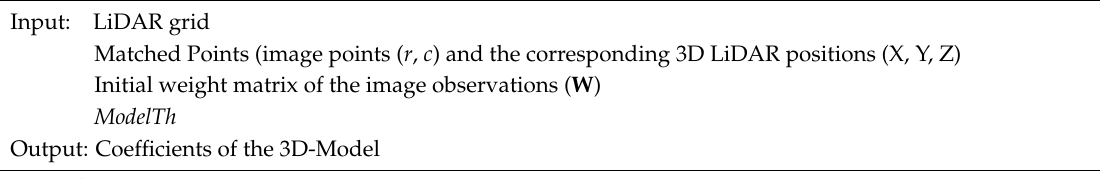
values of NrHOS from 2 to 20. different